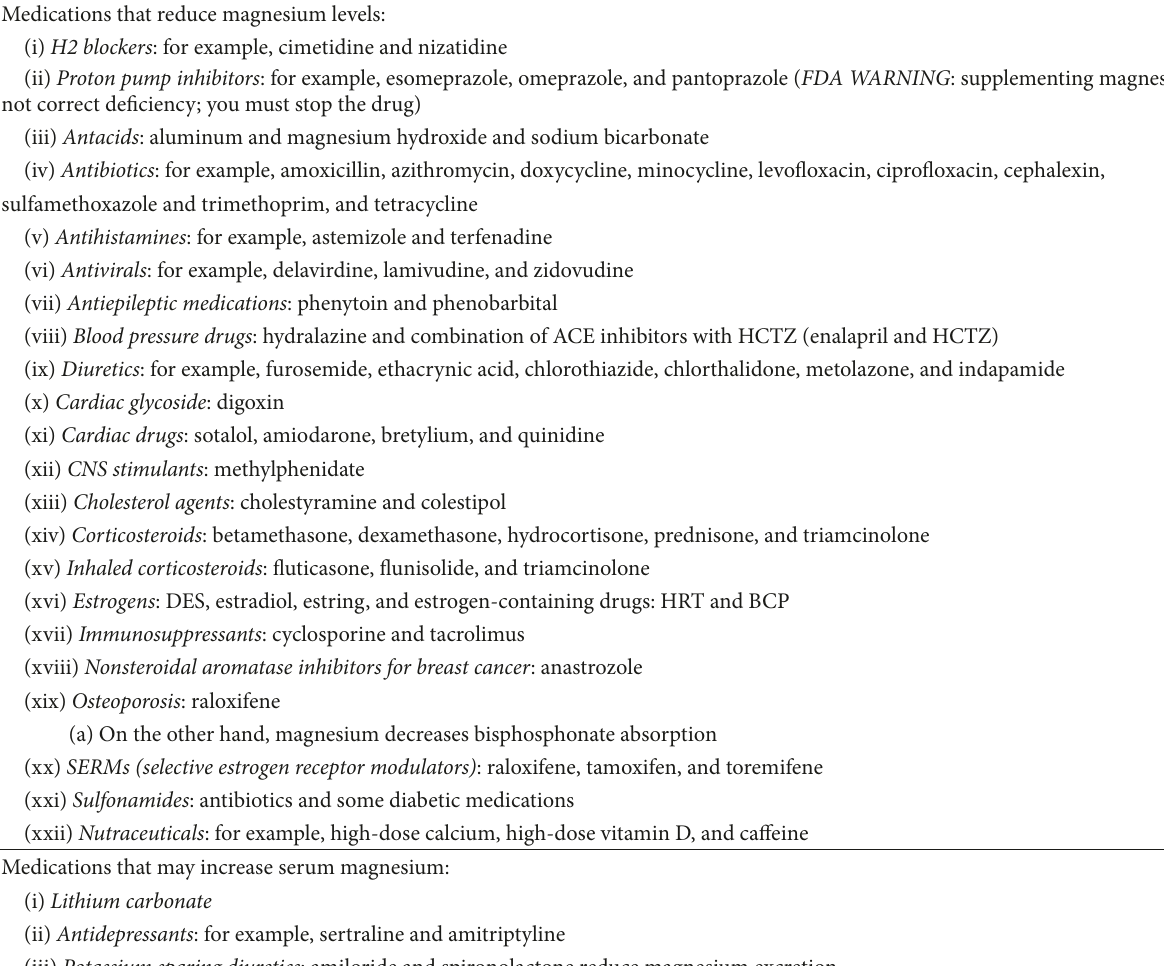
Table 8: Magnesium and drug